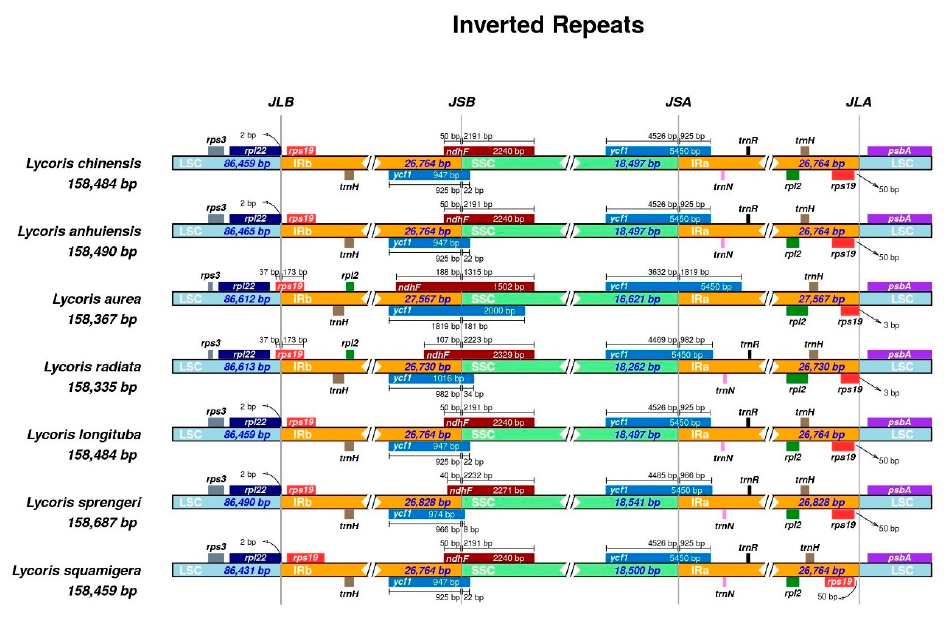
Figure 3. Comparison of boundary distance of large single-copy regions (LSC), small single-copy regions (SSC), and an inverted repeat (IR) among seven Lycoris chloroplast genomes.